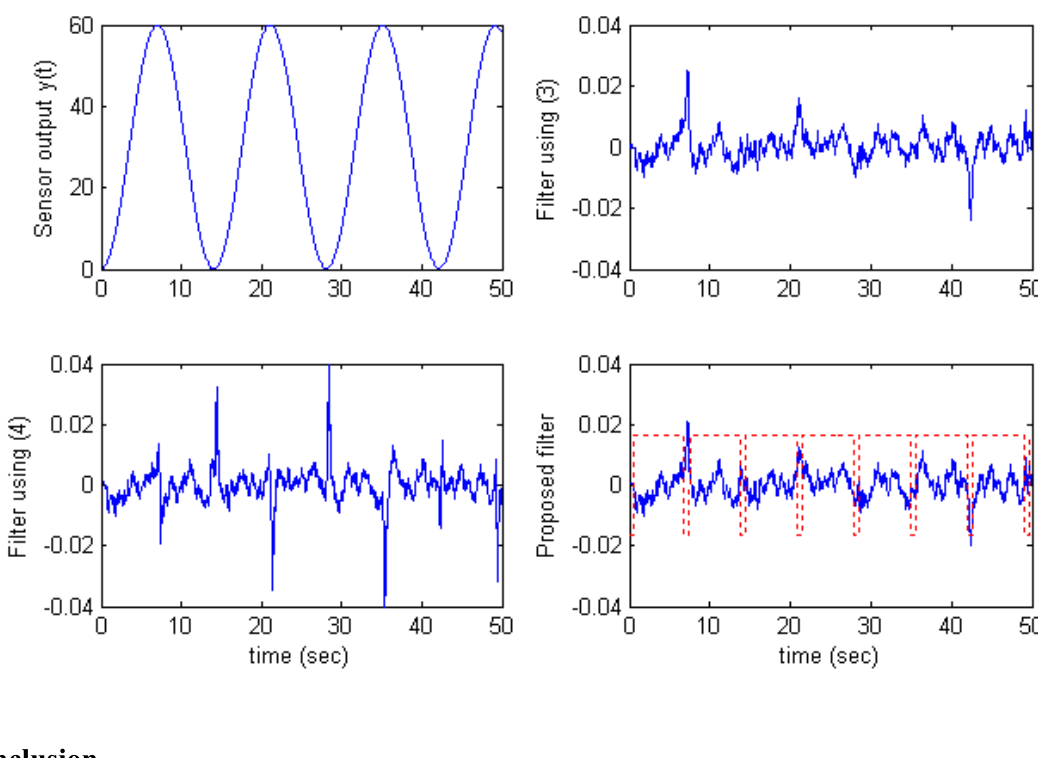
Figure 6. Estimation error of 3 filters ( 0.2 δ = ) in case